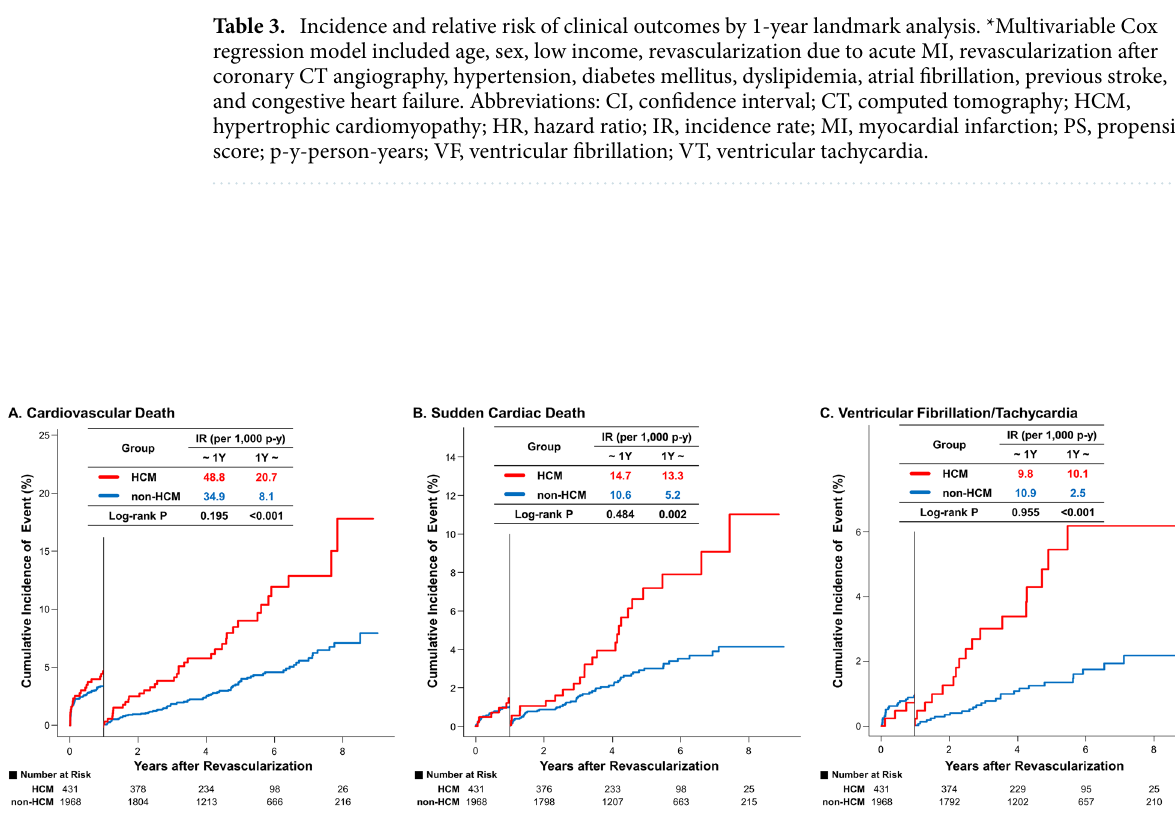
Figure 3. Landmark analysis of major cardiovascular outcomes in HCM versus non-HCM control group. Cumulative incidence and 1-year landmark analyses of ( A ) Cardiovascular death, ( B ) Sudden cardiac death, and ( C ) Ventricular fibrillation/tachycardia is presented. Abbreviations: HCM, hypertrophic cardiomyopathy; IR, incidence rate; p-y, person-year; Y,